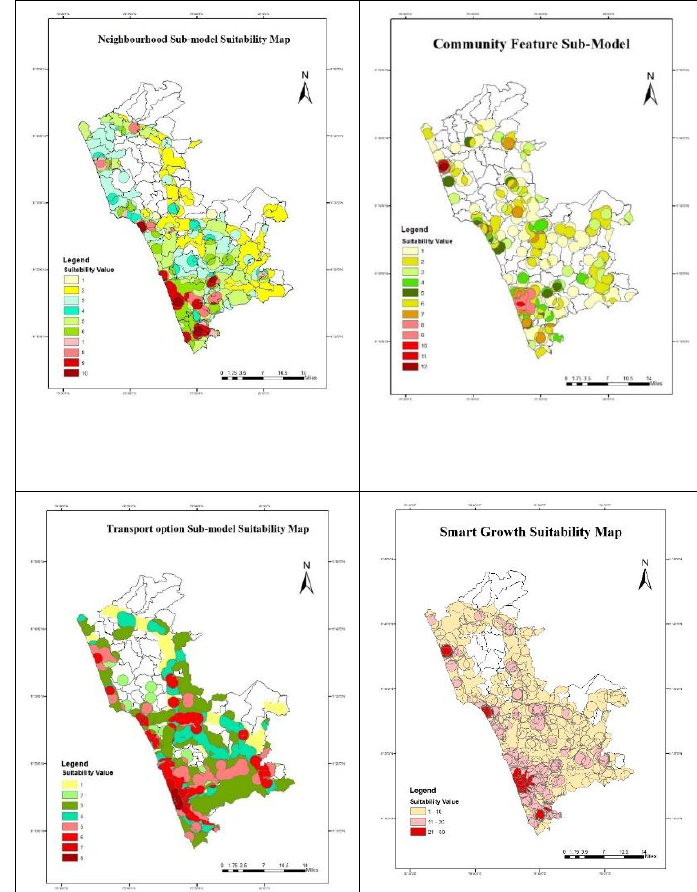
Figure 6. (a) Neighbourhood features Suitability map of KUA, (b) Community forms Suitability map of KUA, (c) Transport options Suitability map of KUA, and (d) Smart growth suitability map of